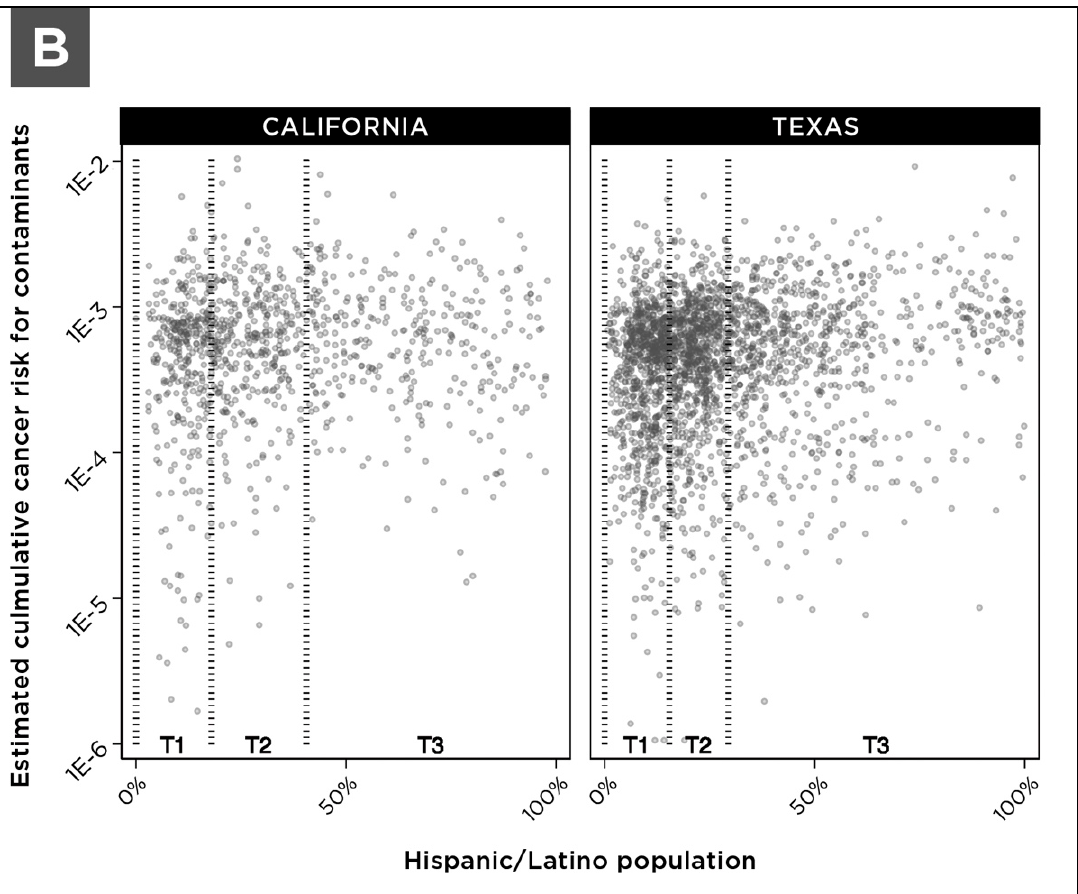
Figure 8. Distribution of cumulative cancer risk for community water systems in California and Texas divided into terciles according to the ( A ) percentage of the population that is Black/African American and ( B ) percentage of the population that is Hispanic/Latino within each system’s service area. The figure includes all systems in each state serving populations greater than 500 people. Terciles are indicated as T1, T2, and T3, and tercile boundaries are listed in Appendix A, Table